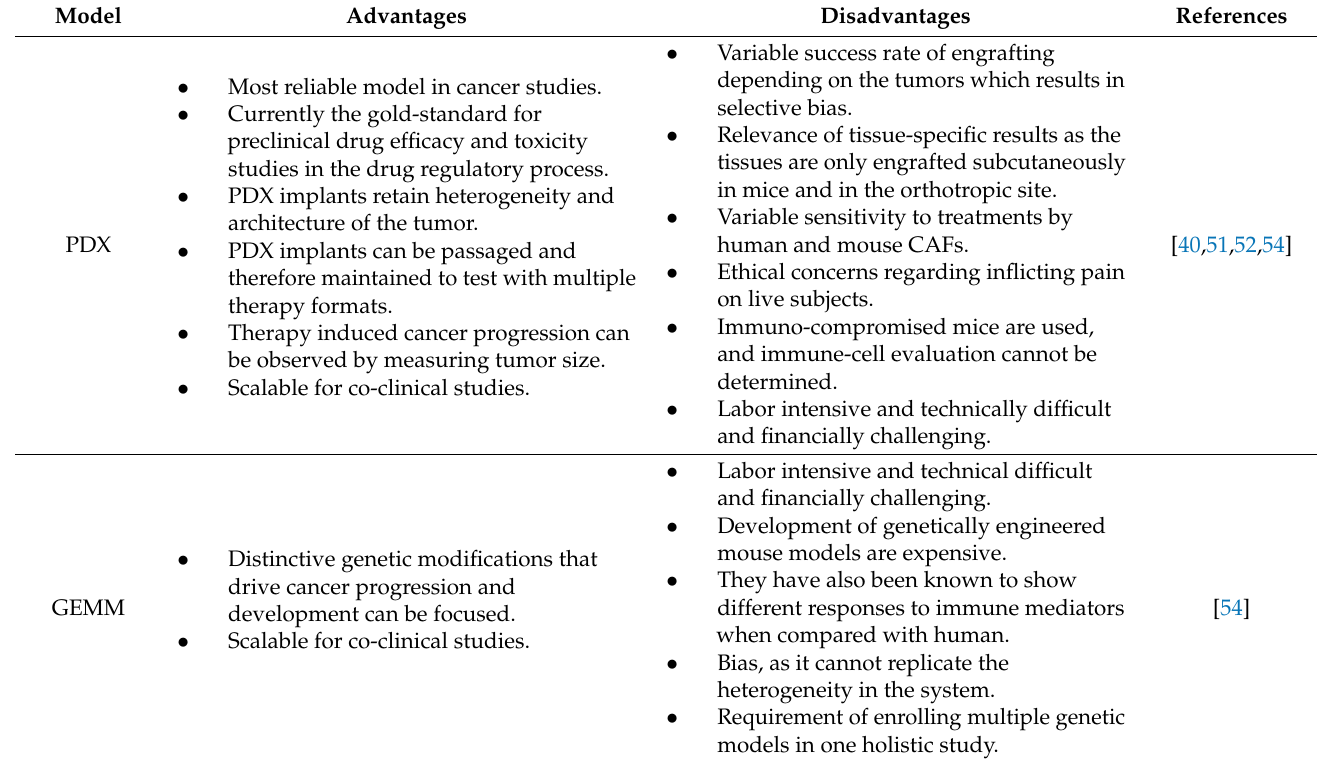
Table 2. Advantages and disadvantages of animal models in co-clinical